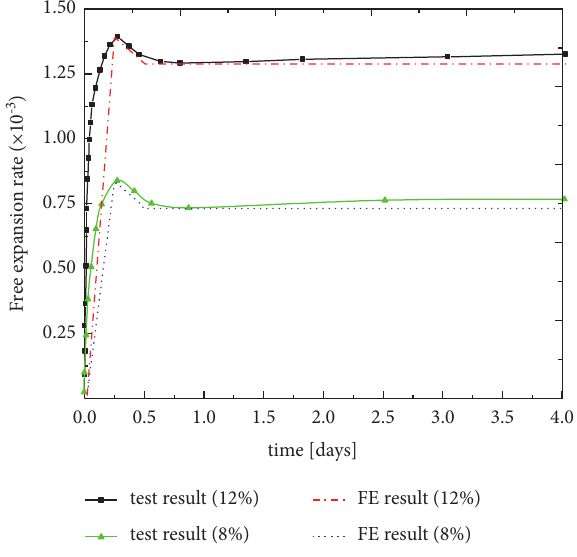
Figure 11: Temperature equation curve.